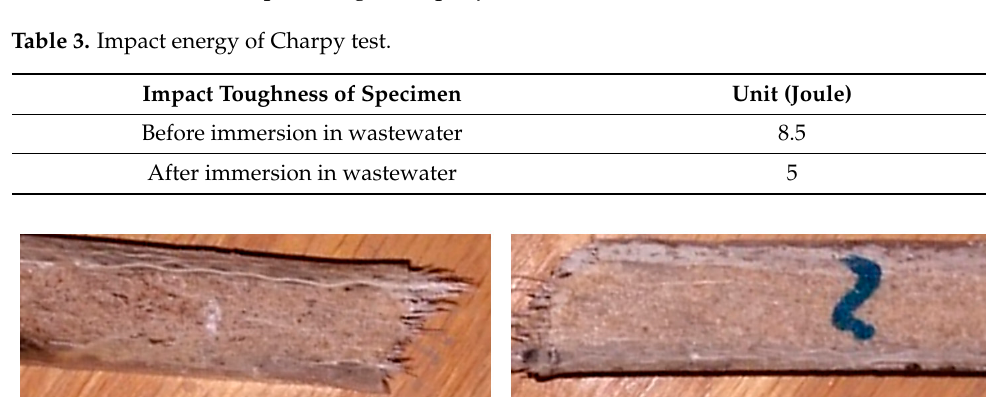
Figure 15. Within the photo of an impact fracture, the mode of failure can be seen.